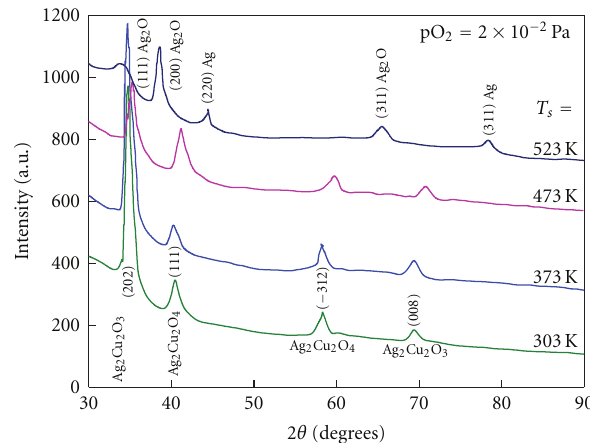
Figure 2: X-ray di ff raction profiles of Ag-Cu-O films formed at di ff erent oxygen partial pressures: (a) 5 × 10 − 3 Pa, (b) 2 × 10 − 2 Pa, and (c) 5 × 10 − 2 Pa.